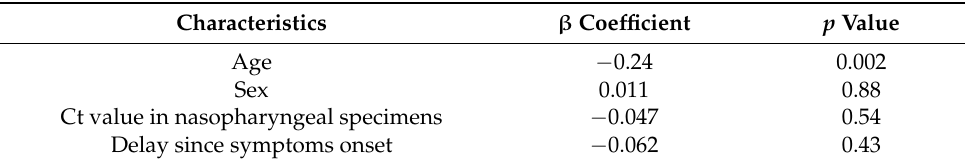
Table 4. Factors associated with IFN α levels in COVID-19 outpatients (linear regression). Characteristics β